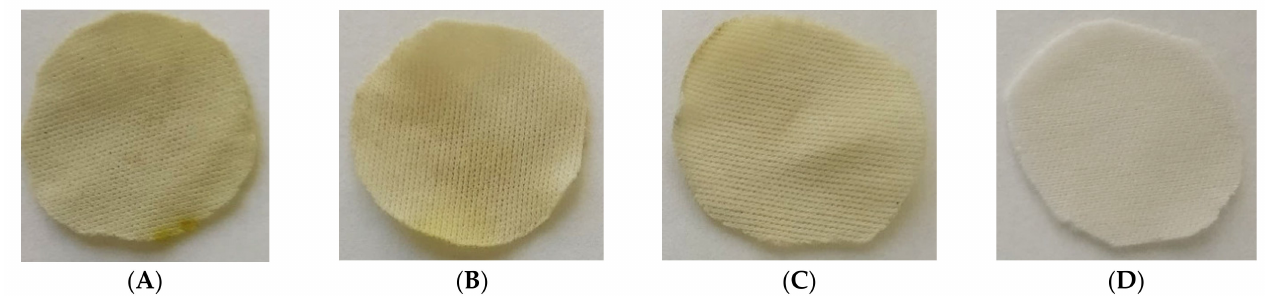
Figure 7. The first three images on the left are the dressings impregnated according to the following conditions: ( A ) 5% ETOH—2.5 mg ALE/100 mg PD, ( B ) 5% ETOH—5.3 mg ALE/100 mg PD and ( C ) 10% ETOH—5.3 mg ALE/100 mg PD, ( D ) is an non-impregnated sample.